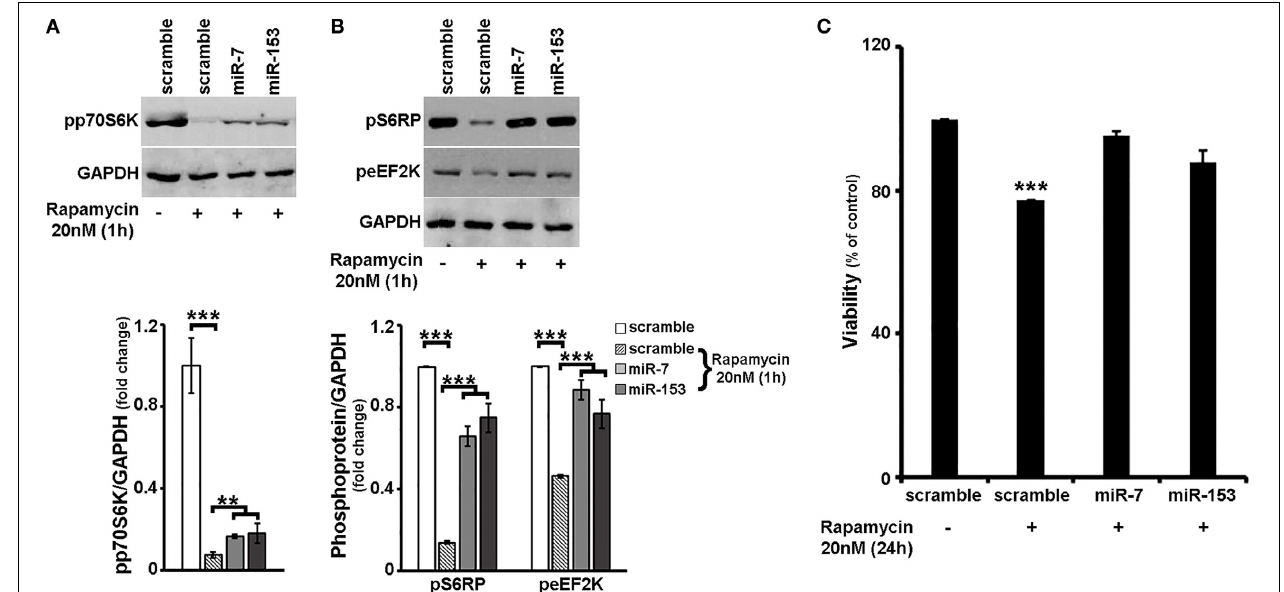
FIGURE 5 | Overexpression of miR-7 or miR-153 attenuated the effects of rapamycin in cortical neurons. (A,B) Six to seven days old primary cortical neurons were transduced with adenoviral particles expressing scramble miR, miR-7, or miR-153 and left in culture for additional 48h. One hour before harvest, cultures were supplemented with 20nM rapamycin. Equal amounts of total protein from lysates of cortical neurons were analyzed on 10% SDS-PAGE and immunoblotted with antibodies specific for phosphorylated forms of p70S6K, S6RP, and eEF2K. To ensure equal loading, membranes were re-probed against GAPDH. Quantification of the results was performed